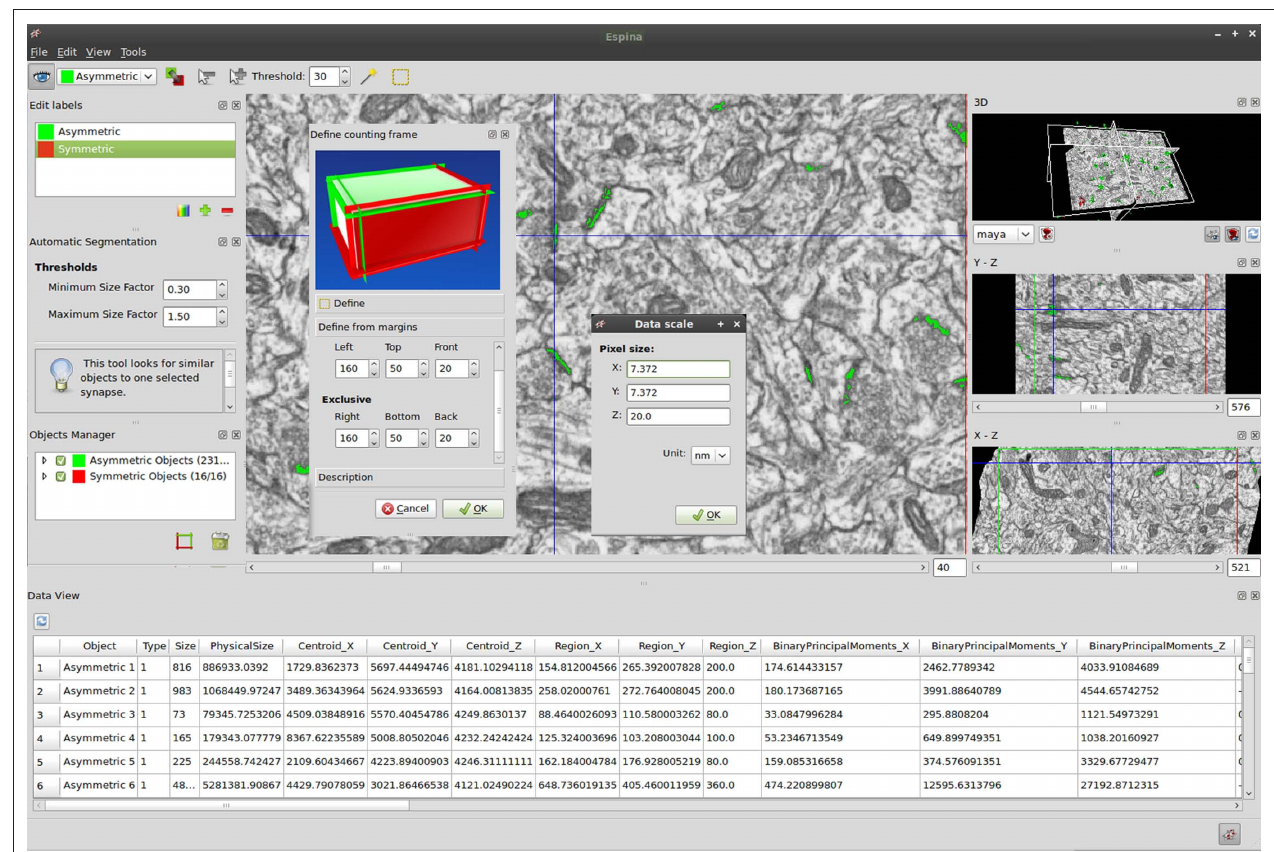
main window, the acceptance planes (in green) correspond to the front, top and left sides of the stack while the exclusion planes (in red) are the back, right, and bottom sides. The “Data viewer” window shows different geometrical values extracted from the reconstructed 3D objects (see text for